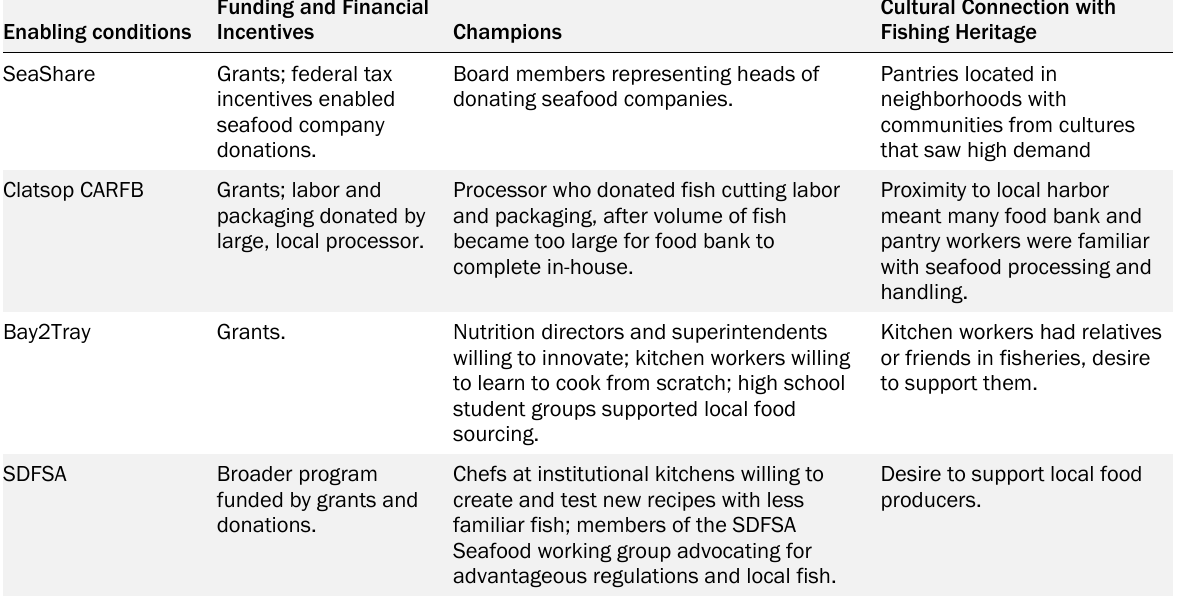
Table 3. Enabling Conditions of Positive Deviant Cases Enabling